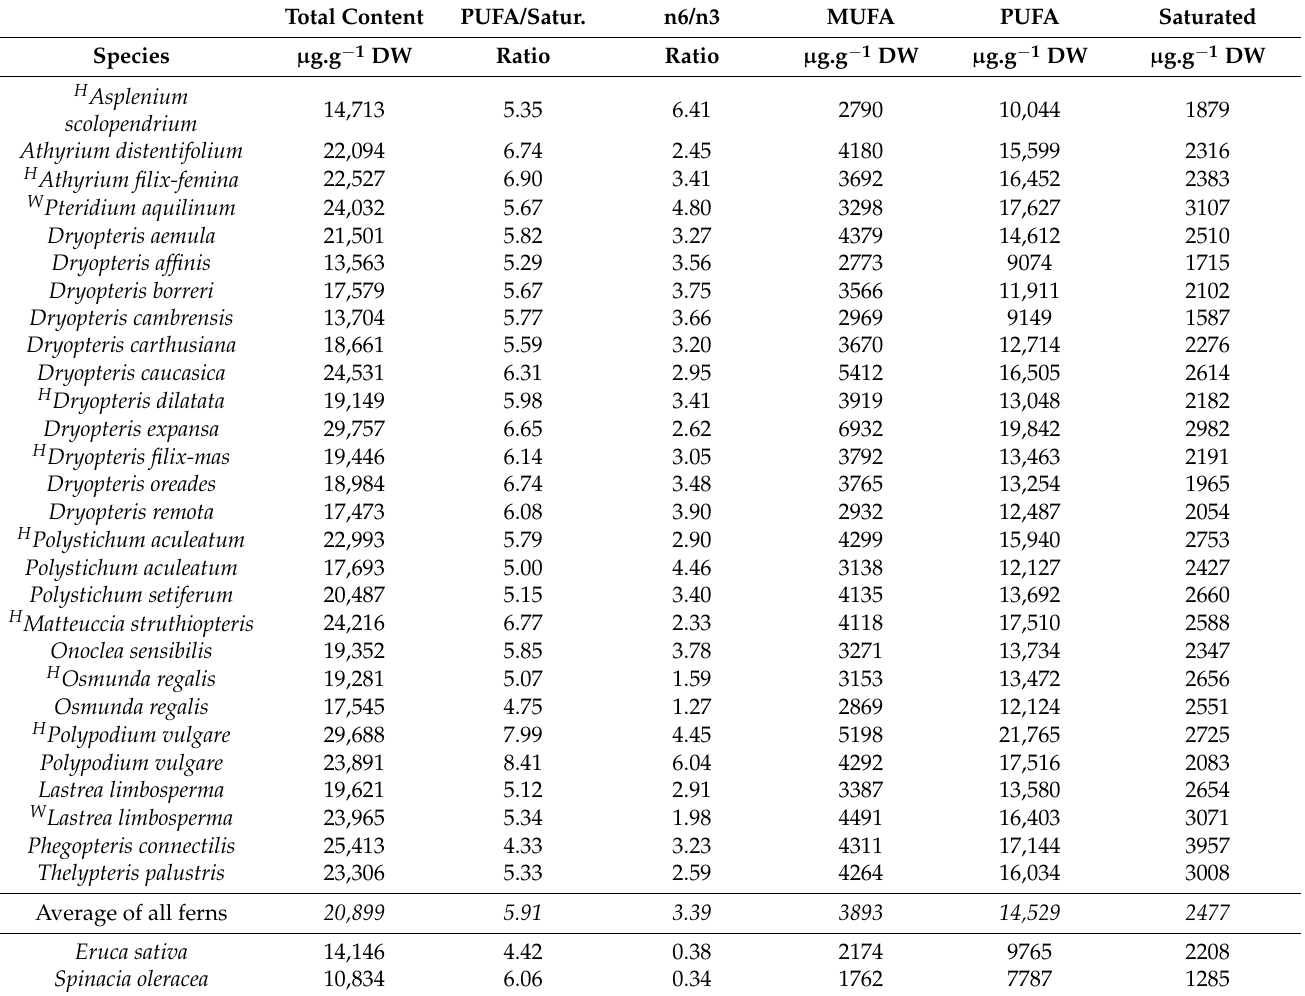
Table 4. Total content of FAMEs in fiddleheads of tested individual fern